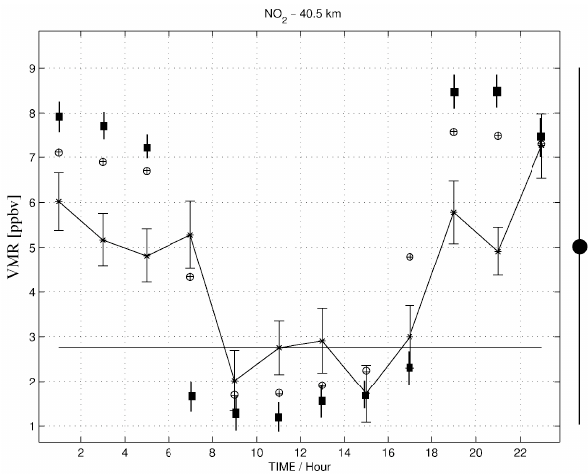
Fig. 16. Diurnal variations of NO 2 at 40.5km as measured by the ground-based microwave radiometer (stars) and by the UARS/CLAES instrument (filled squares). Ground-based NO 2 measurements are representative of a 3-month average of the re- trievals from January to March 1995. Satellite data have been zonally-averaged within the latitude band 40 ◦ N–50 ◦ N for the months of February 1992 and 1993 in 12 boxes of a 2-hour width. A priori VMR (solid line), and calculations from the 0-D model on 15 January: run A (crosses) and run B (open circles). Note that vertical resolution of the model and of the satellite data has been degraded to match the resolution of the ground-based measurements. Only an uncorrelated 1- σ error due to the thermal noise is considered in the errorbar. A systematic 1- σ error for the Bure measurements (filled circle and thick line) is represented on the right-hand side of the